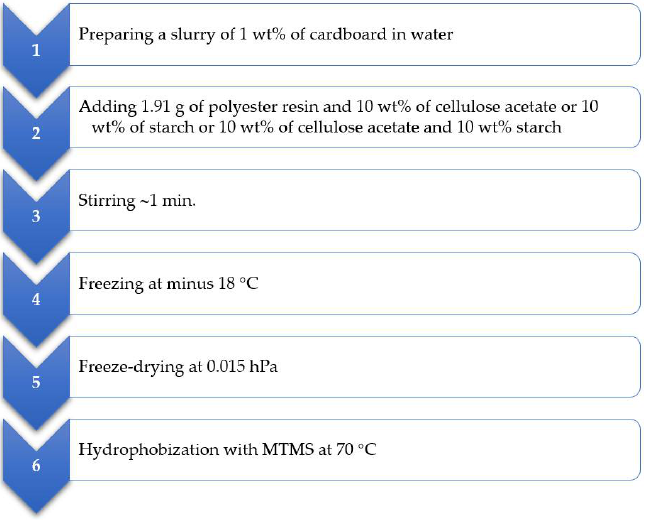
Figure 1. Aerogels synthesis scheme.